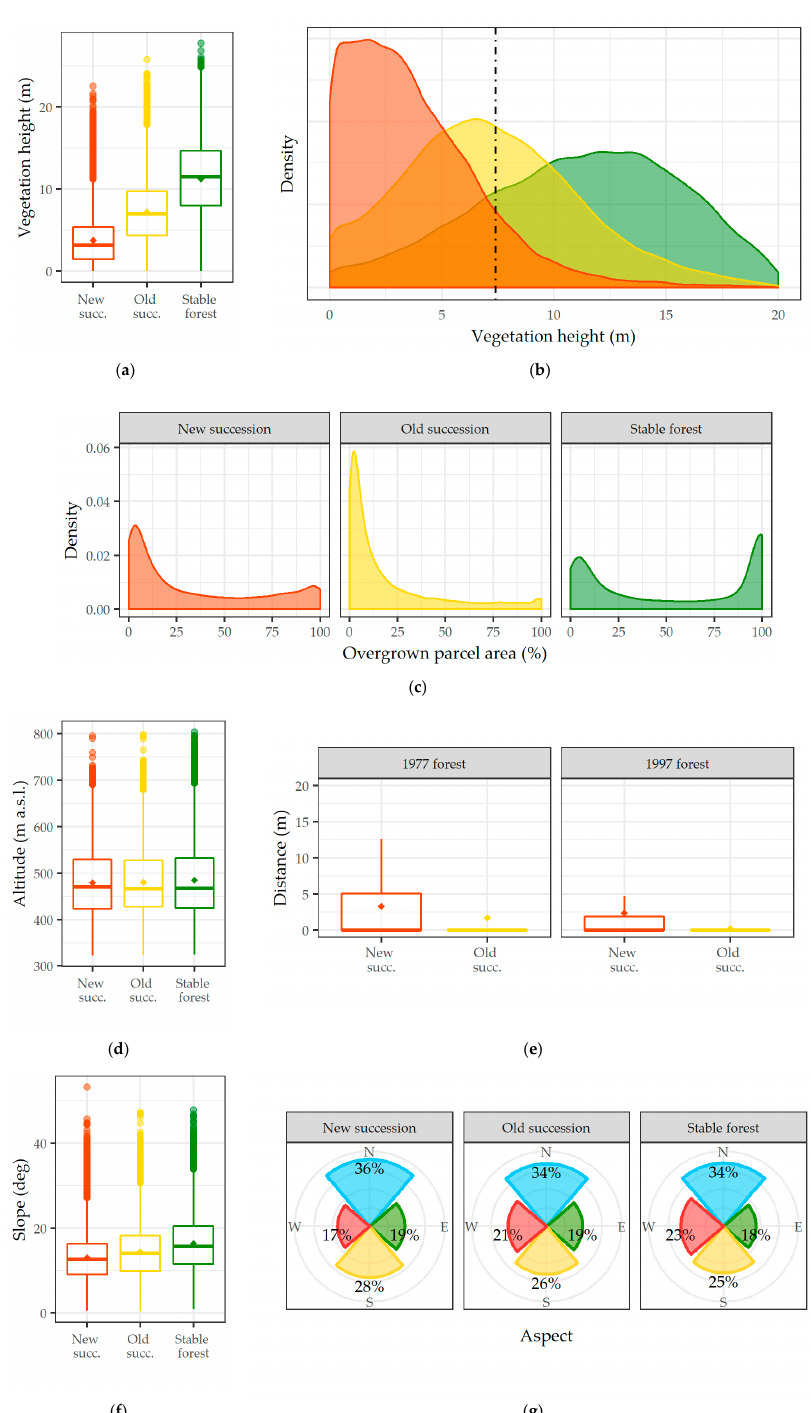
Figure 3. Characteristics of new and old succession, and stable forest patches: ( a ) box plot of the successional and woody vegetation height; ( b ) density plot of the successional and woody vegetation height (Dash-dot line indicates vegetation height threshold discriminating the old and new succession classes.); ( c ) density plot of the proportion of overgrown parcels area; ( d ) box plot of the altitude; ( e ) box plot of the distance to forest in 1977, 1997, and 2009; ( f ) box plot of the slope; and, ( g ) distribution of the aspect; In box plots ( a , d , e , f ), the horizontal line within the box indicates the median, boundaries of the box indicate the 25th—and 75th—percentile, the diamond indicates mean value, and the individual data points indicate outliers. For patches of stable forest, and old and new succession, vegetation height was positively correlated with elevation (r = (0.15, 0.05, 0.16), p = (0.96, 0.73, 0.96), respectively) and slope (r = (0.22, 0.14, 0.16), p = (0.81, 0.66, 0.56), respectively), and almost zero correlation was observed with cadastral